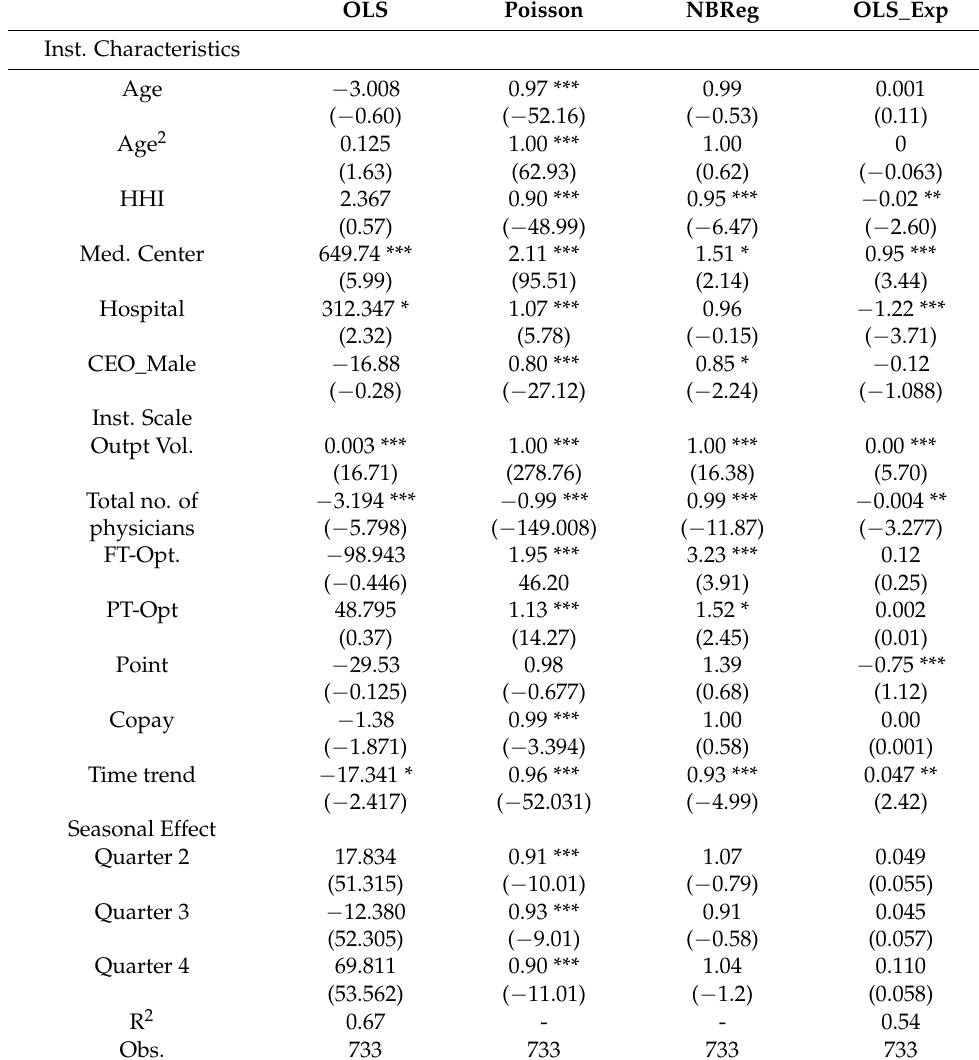
Table 4. Regression Results for Institution’s Outpatient Visits–Institution-level Data. OLS Poisson Inst.